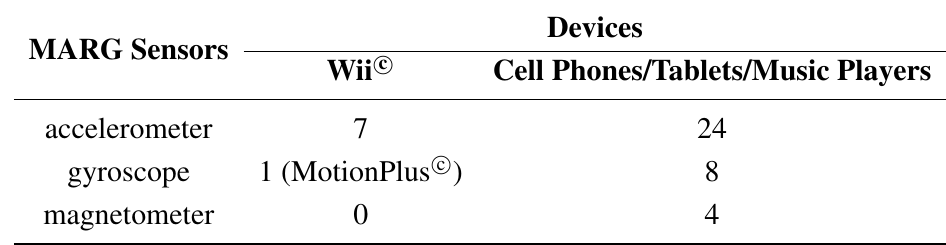
Table 4. Co-occurrence matrix of MARG sensors in portable consumer electronic